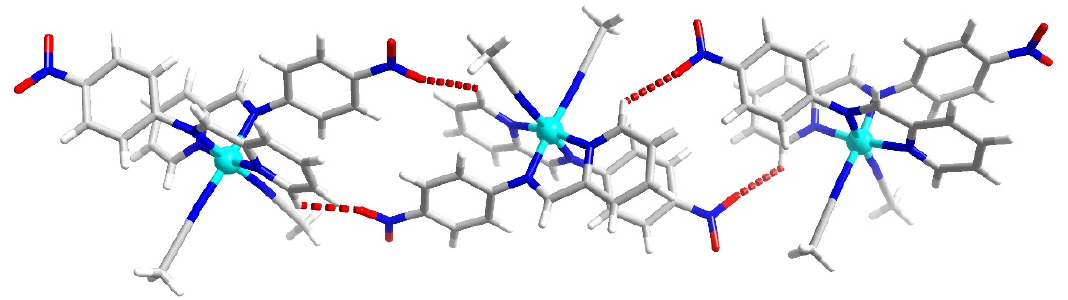
Figure 3. Intermolecular hydrogen bonding interactions (CH…O) in complex 3 , forming a 1-D supramolecular network in the crystallographic (101) plane.